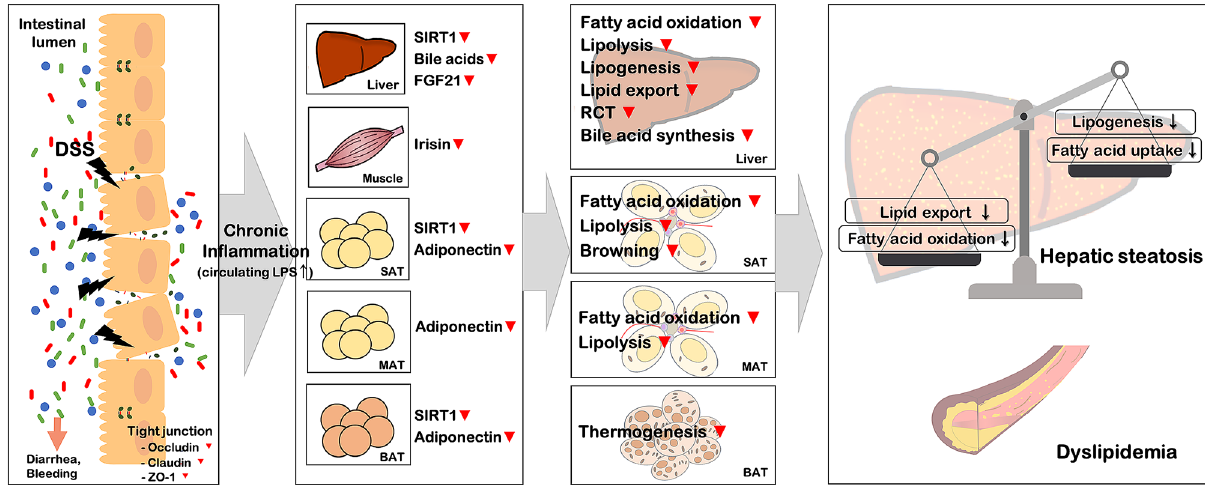
Figure 8. A potential molecular mechanism for how DSS-induced colitis is linked to metabolic-dysfunction phenotypes, i.e. hepatosteatosis and